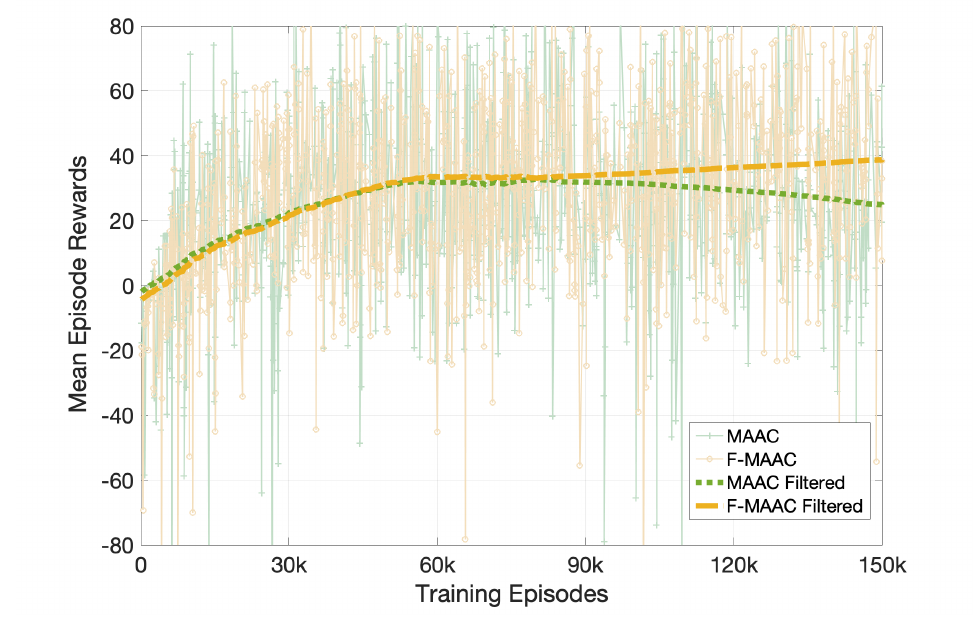
Figure 10. Mean episode rewards of the MAAC and F-MAAC models for 150k episodes.